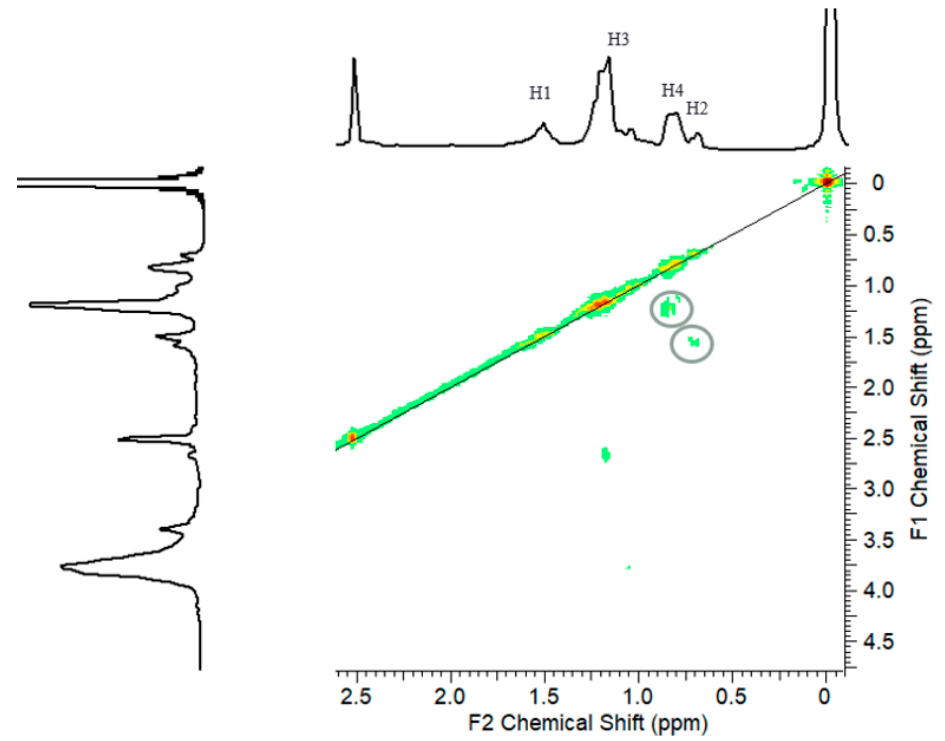
Figure 4. 1 H– 1 H COSY spectrum of KL- g -PS in DMSO.